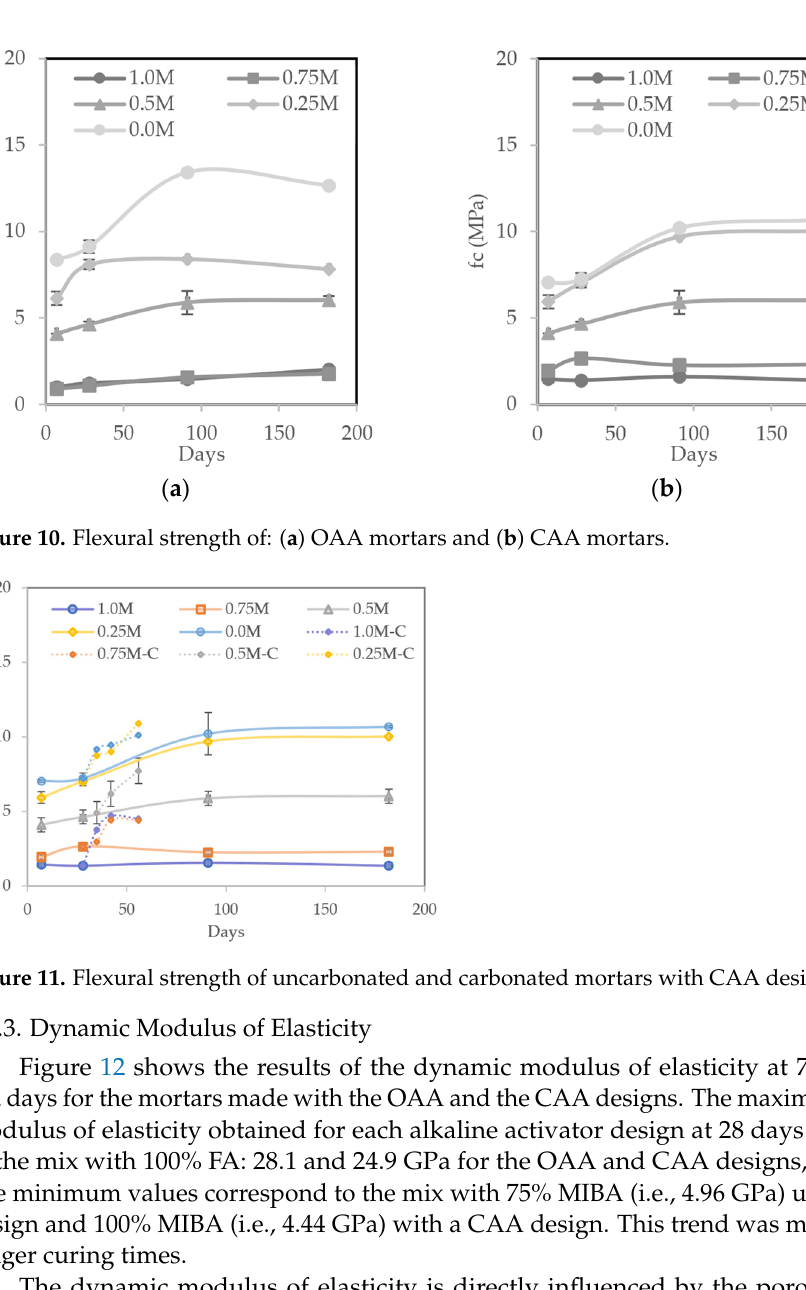
Figure 11. Flexural strength of uncarbonated and carbonated mortars with CAA design.